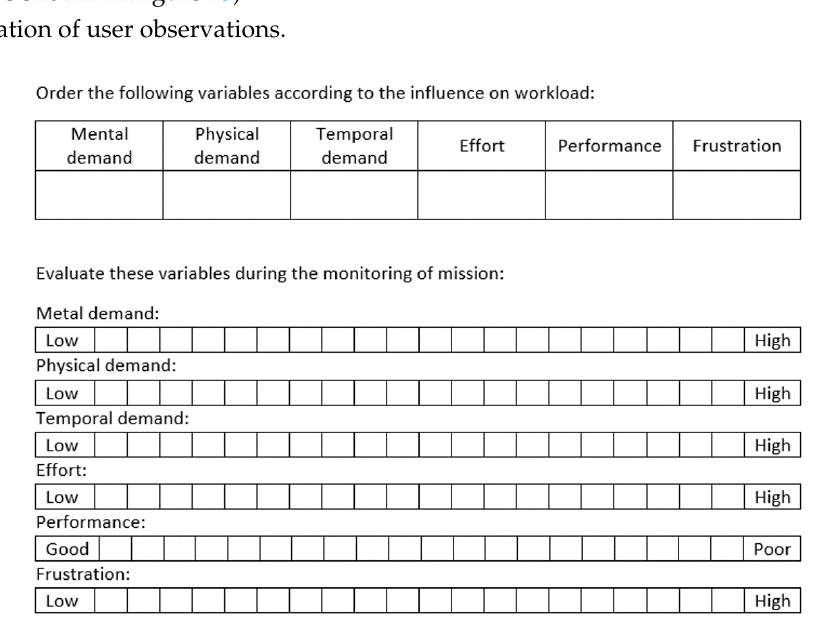
Figure 13. NASA Task Load Index (NASA-TLX): English translation of the questionnaire of the